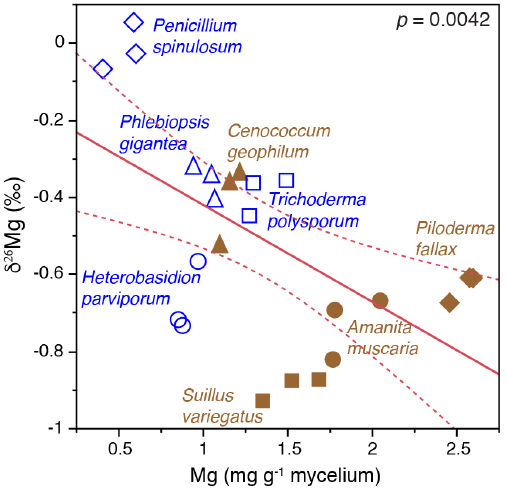
Figure 5. Bivariate plots of δ 26 Mg (‰) versus Mg concentration (mgg − 1 ) in mycelia of ectomycorrhizal and nonmycorrhizal fungi grown on mineral-free modified Melin-Norkrans (MMN) medium amended with granite particles. The fungi were grown on cello- phane membranes covering the growth substrates in Petri dish mi- crocosms. Open blue symbols represent nonmycorrhizal fungi and closed brown symbols represent ectomycorrhizal fungi. (Figure is reproduced with permission; Fahad et al.,